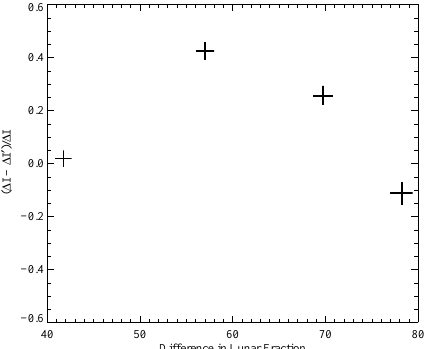
Figure 4. The relative difference in radiance variance for nights with lunar contamination ( (cid:49)I on the y axis label) and without lunar contamination ( (cid:49)I (cid:48) ). Each point consists of a pair (one light, one dark) of retrievals with similar (within 0.008) τ . The x axis indi- cates the difference in lunar fraction between the paired retrievals. The symbol sizes represent the magnitude of HSRL τ values, which range from 0.15 to 0.25.